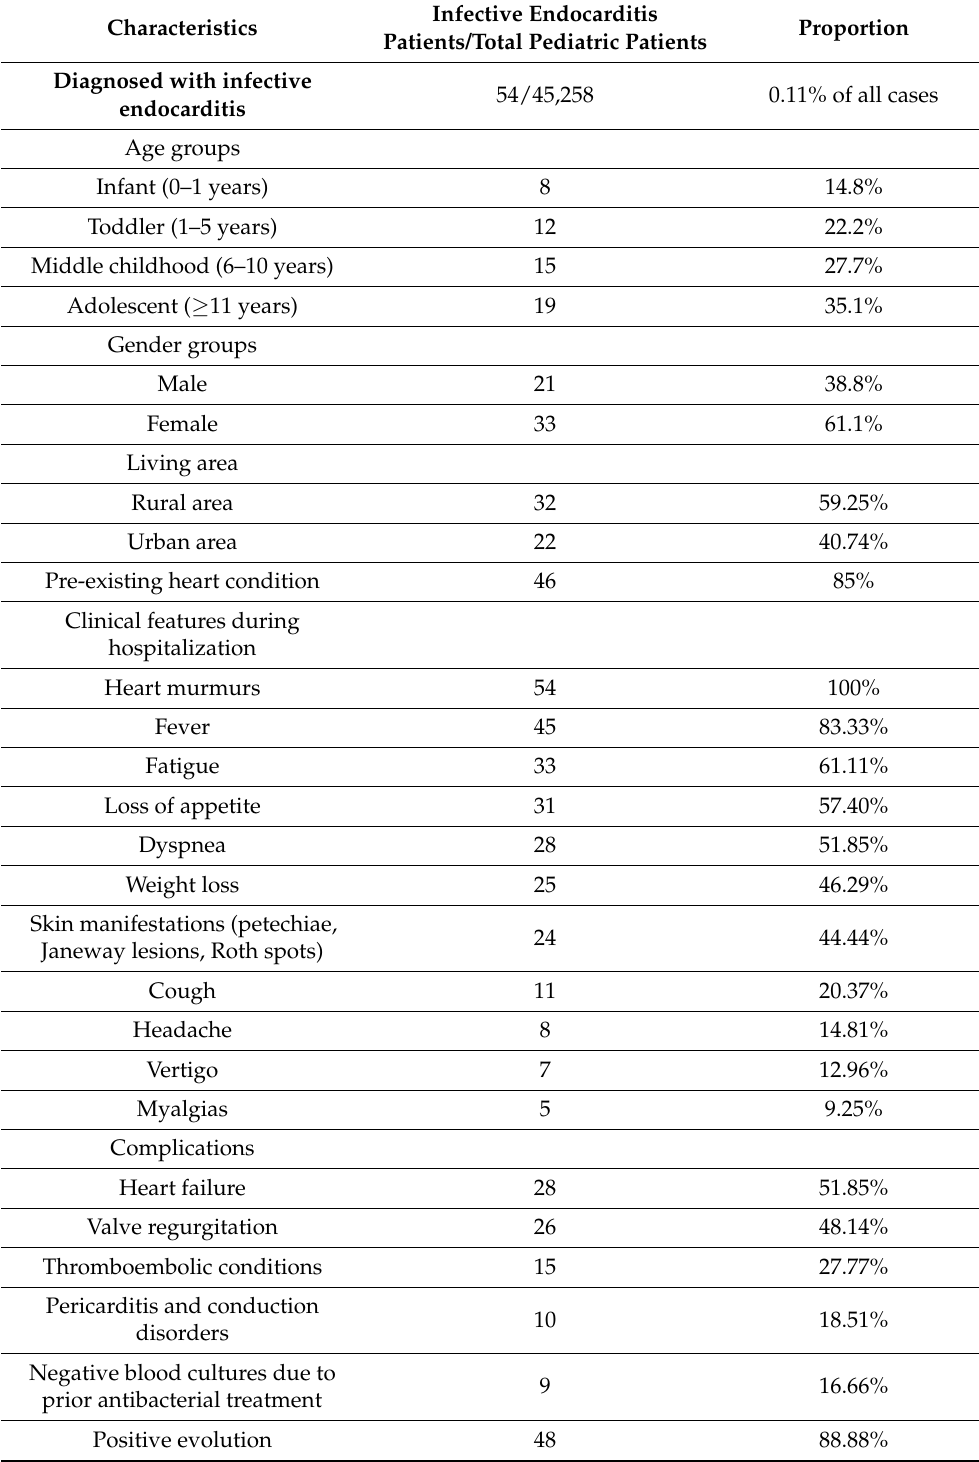
Table 1. Baseline characteristics of the overall